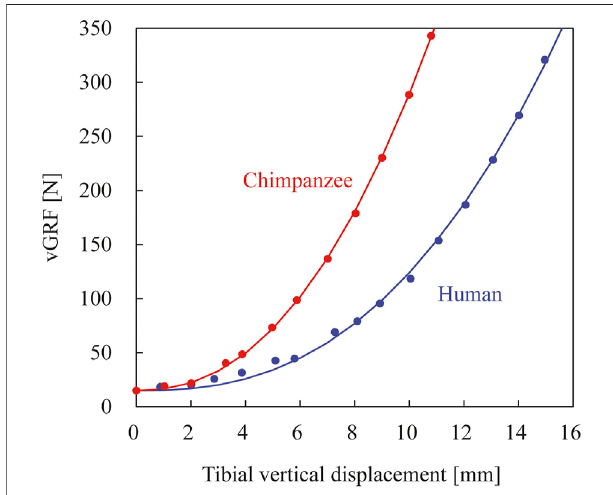
FIGURE 7 | Simulated force – displacement curves of human and chimpanzee feet during axial loading without tendon traction. Blue and red lines represent those of human and chimpanzee, respectively. Curve fi tted using exponential functions (see Methods